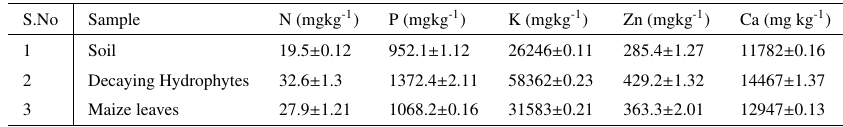
Table 1. Concentration of minerals nutrient concentration in soil, hydrophytes and maize leaves (n = 5).